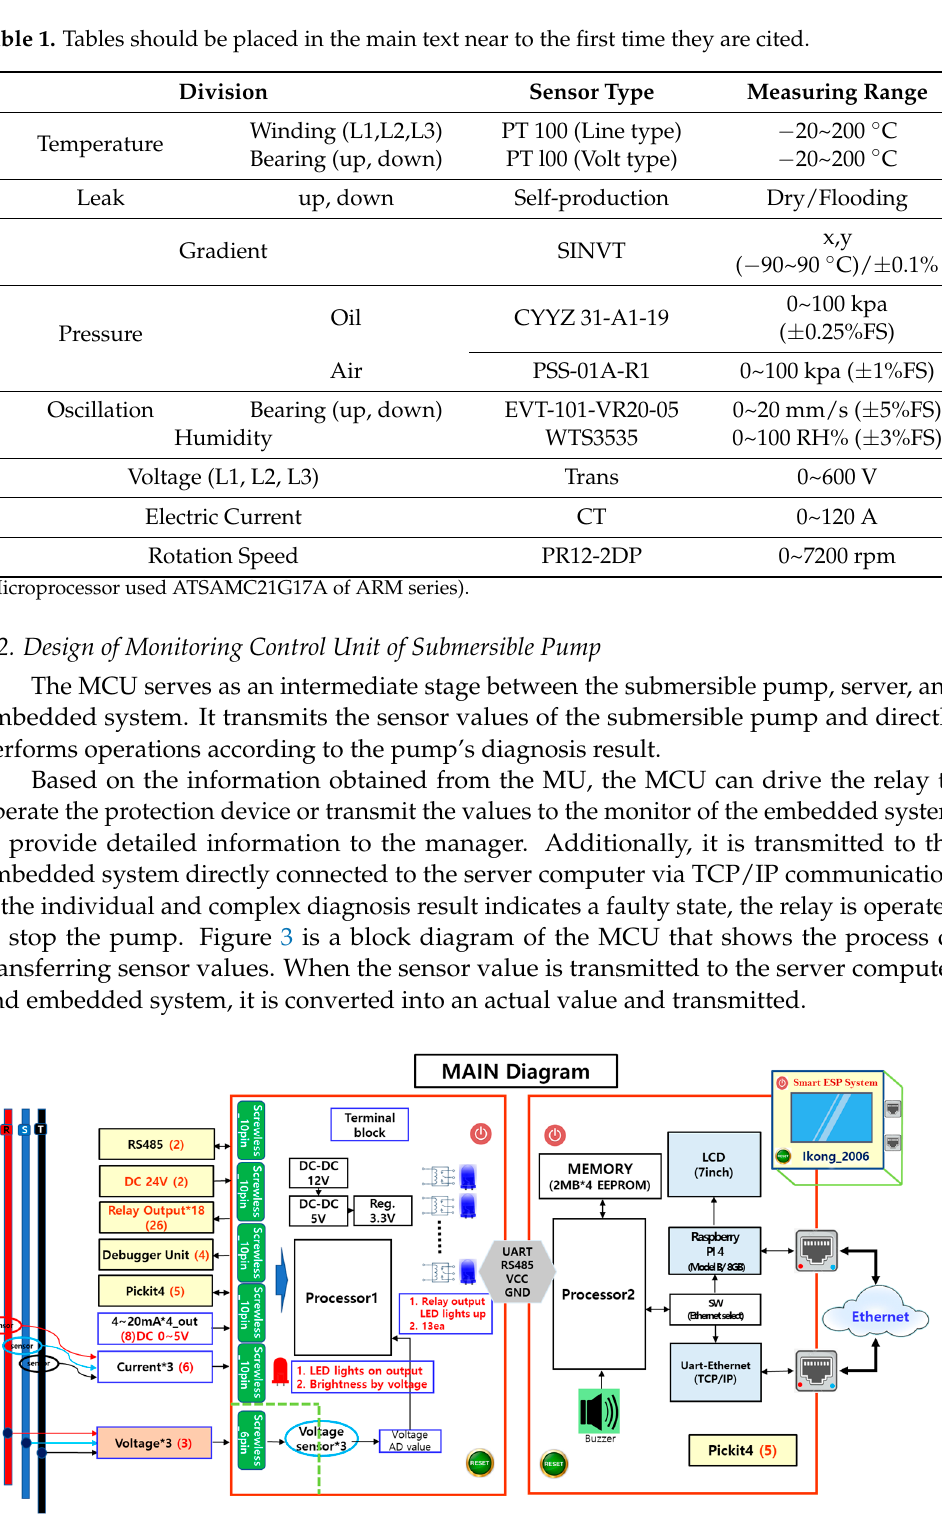
Figure 3. MCU block